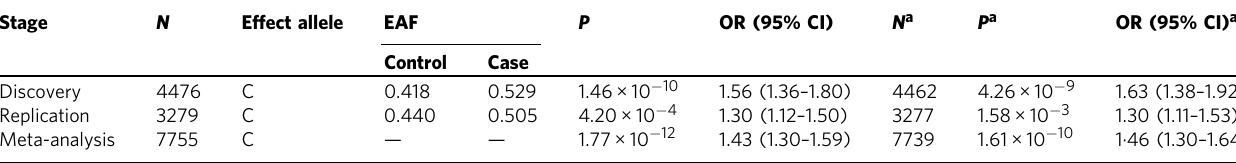
Table 1 Association of rs11873439 (chromosome 18, position 66744288) with myopic maculopathy in the Nagahama cohort